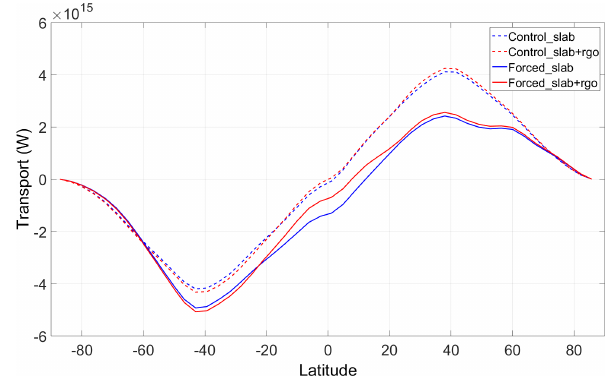
Figure 7. Northward atmospheric energy transport for the ex- periments: Control_slab , Control_slab + rgo , Forced_slab and Forced_slab + rgo